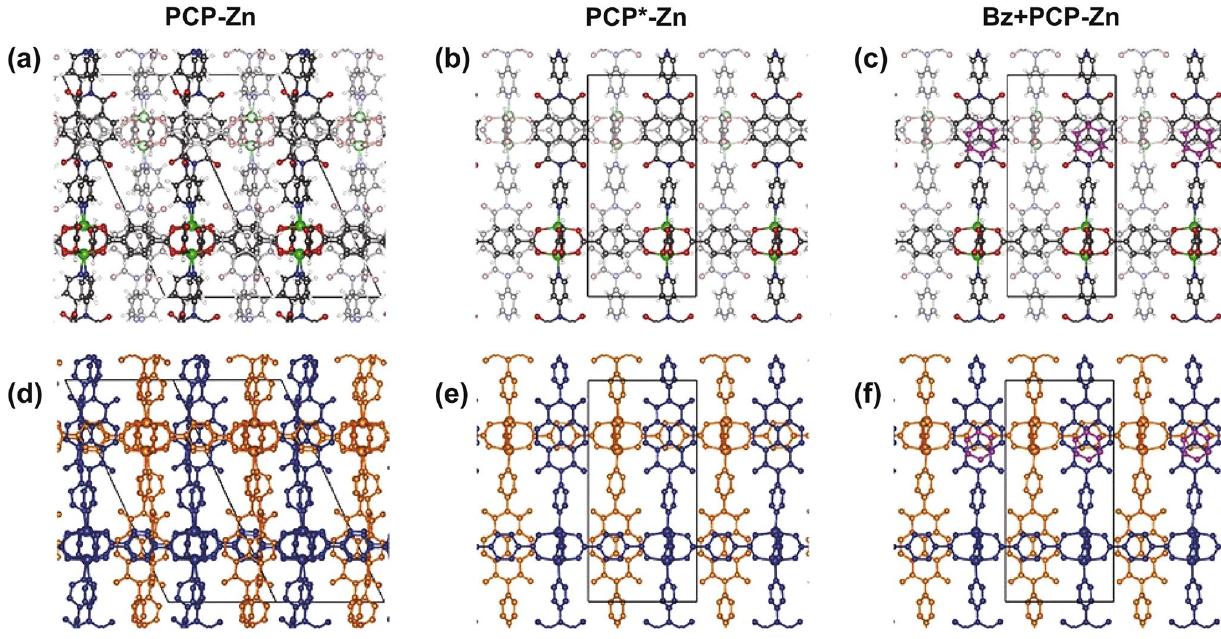
Fig. 19 a PCP-Zn: Structure of pristine MOF before guest molecule introduction. b PCP*-Zn: Structure after guest-molecule-induced structural change, but without guest molecule. c Bz + PCP-Zn: Structure after adsorption of benzene in the MOF. d–f The same structures as a-c with sub- frameworks colored as blue (subframework 1) and orange (subframework 2) and the hydrogens removed for clarity. Reproduced with permission from Ref. [55]. Copyright 2019, American Chemical